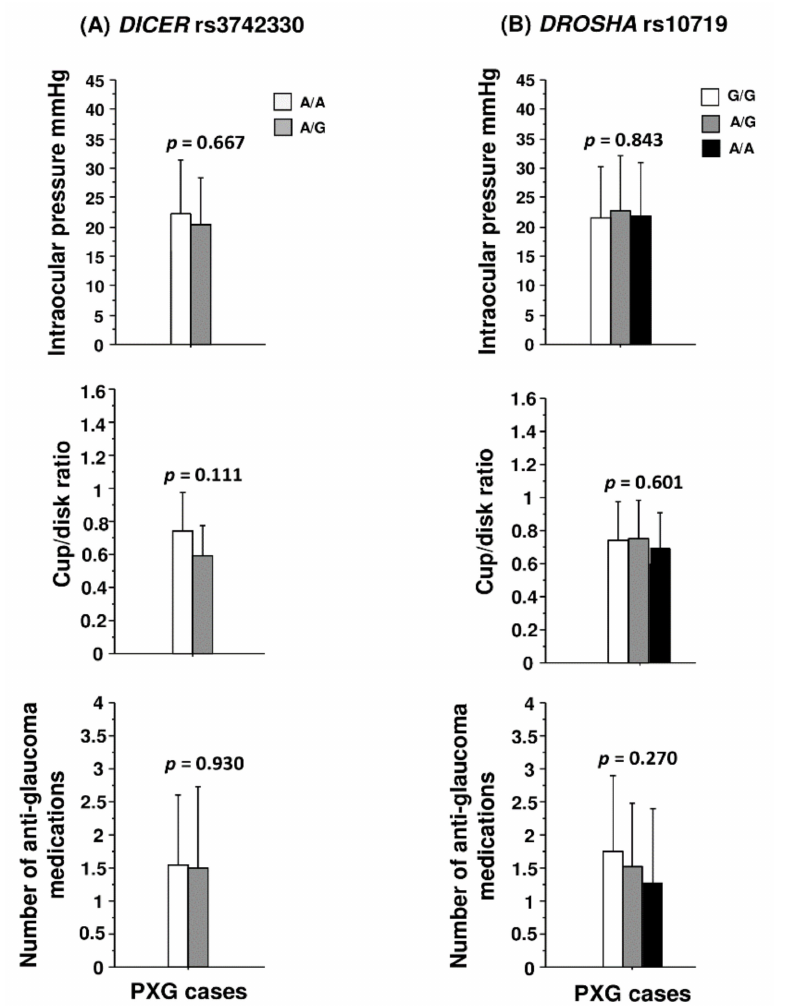
Figure 1. Genotype effect of ( A ) rs3742330 ( DICER1 ) and ( B ) rs10719 ( DROSHA ) on glaucoma specific clinical indices in pseudoexfoliation glaucoma (PXG). Note: No rare homozygous rs3742330 G/G genotype was observed in pseudoexfoliation glaucoma cases. p -value is based on one-way ANOVA